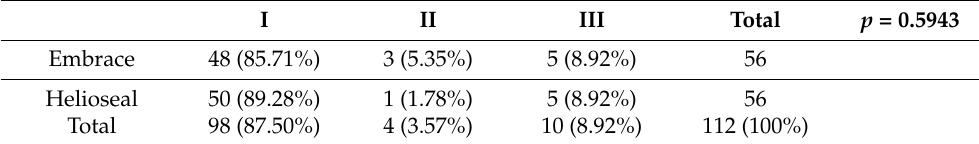
Table 3. Assessment of sealant retention after 18 months according to Simonsen’s criteria.